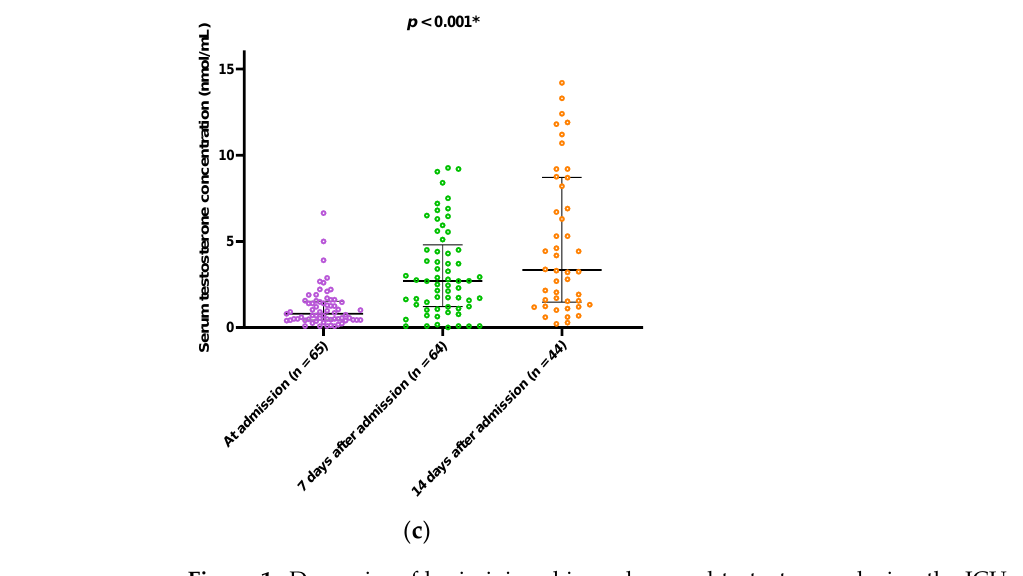
Figure 1. Dynamics of brain injury biomarkers and testosterone during the ICU stay in patients with severe COVID-19: ( a ) dynamics of GFAP during ICU stay; ( b ) dynamics of UCH-L1 during ICU stay. ( c ) Dynamics of serum testosterone during ICU stay; abbreviations: GFAP: glial fibrillar acidic protein; UCH-L1: Ubiquitin carboxy-terminal hydrolase L1; ICU: intensive care unit. Data are presented in the median and interquartile range. * Friedman test. In patients with neurological sequels ( n = 20), UCH-L1 serum concentrations on ad- mission were markedly higher than in patients without them (146.4 (92.5–243.9) pg/mL vs. 240.0 (155.4–366.4) pg/mL, p = 0.022) (Figure 2a). On the other hand, GFAP concentrations on admission did not differ between the two groups of interest (32.2 (24.2–40.1) pg/mL vs. 29.8 (21.8 – 39.4) pg/mL, p = 0.372) (Figure 2b).